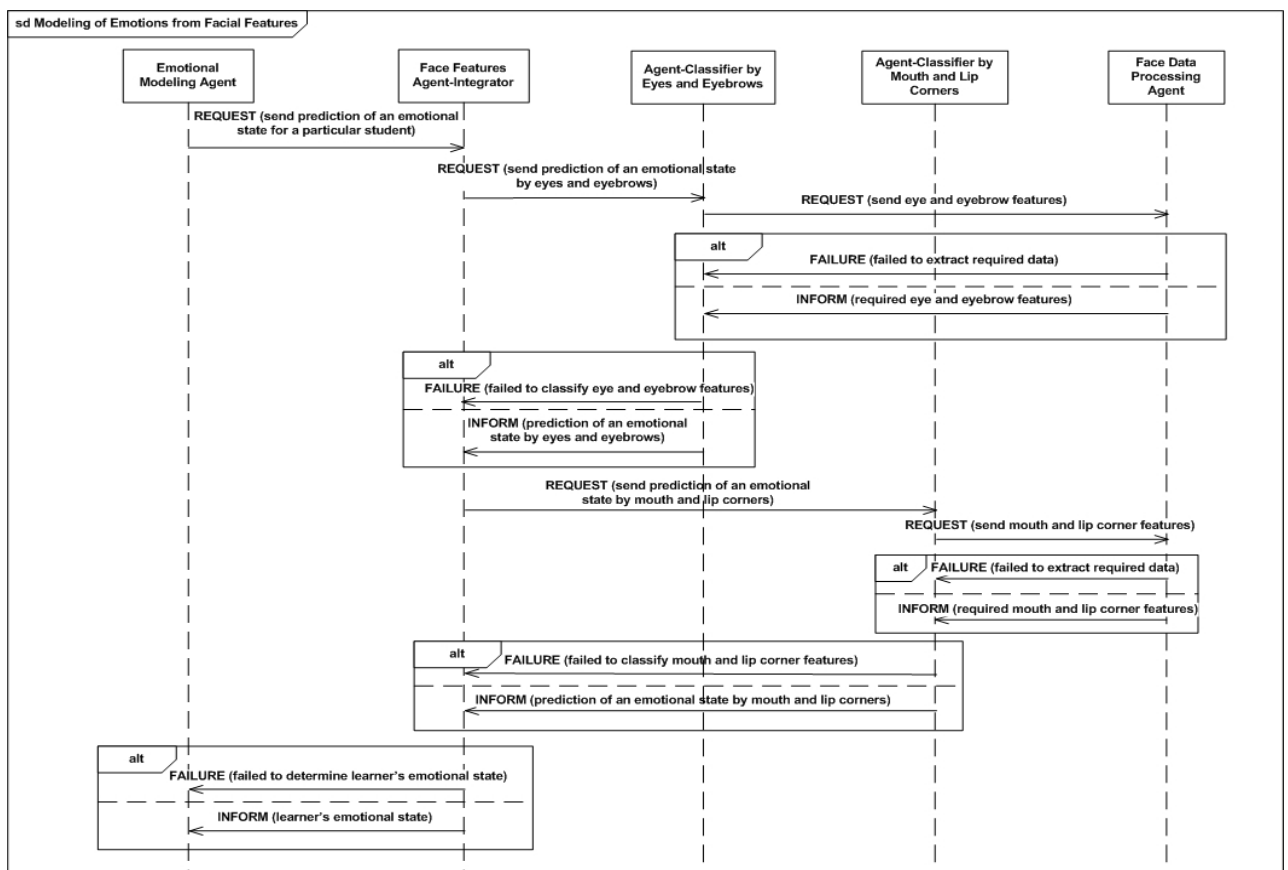
Fig. 6. Modelling of emotions from facial